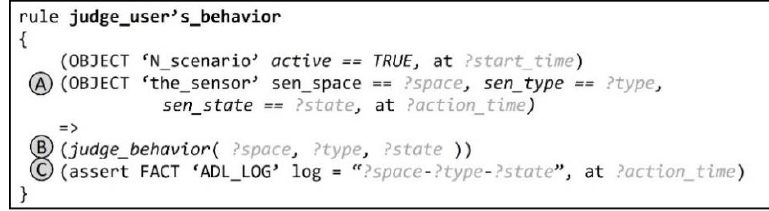
Figure 11. Rule for determining the suitability of a user behavior in an ongoing step.